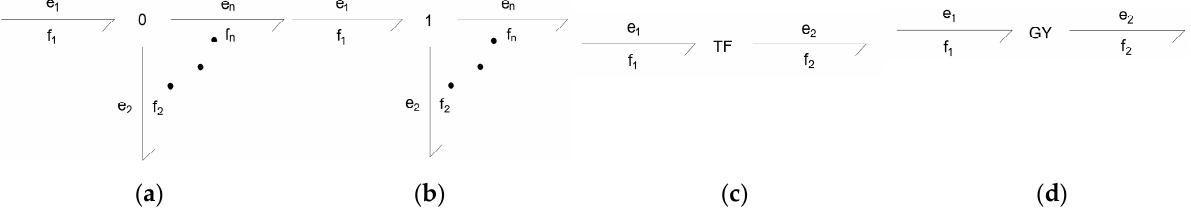
Figure 1. Junctions used in this paper: ( a ) 0-junction; ( b ) 1-junction; ( c ) two-port transformer; ( d ) two-port gyrator. Causal stroke is shown in Figure 2.